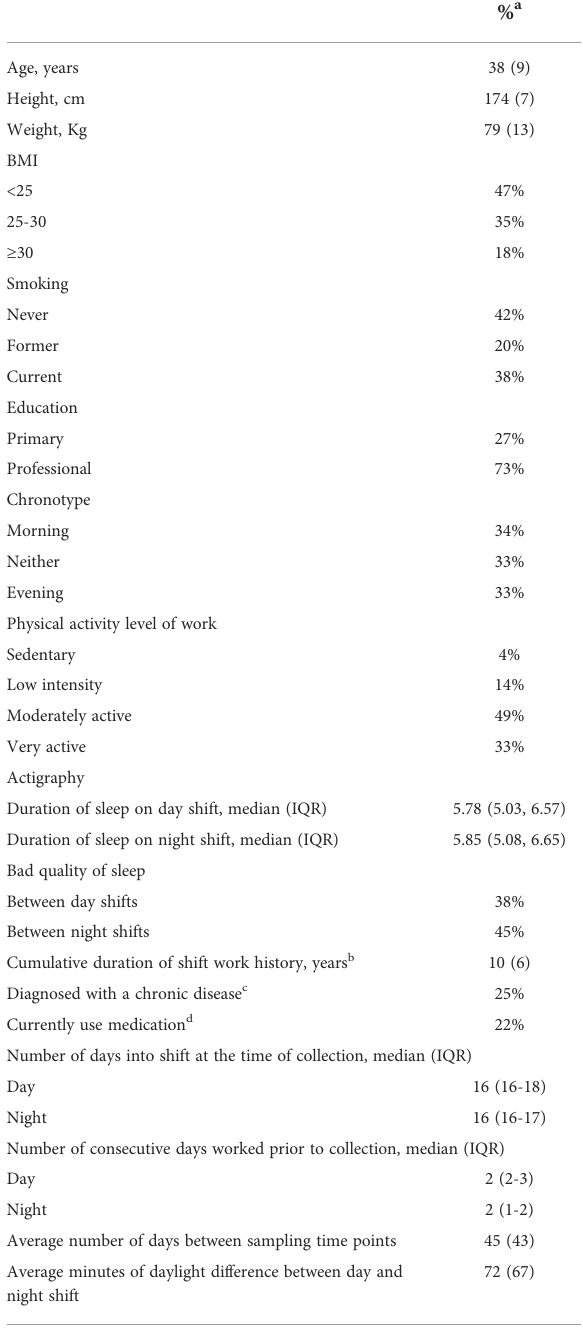
TABLE 1 Characteristics of study population